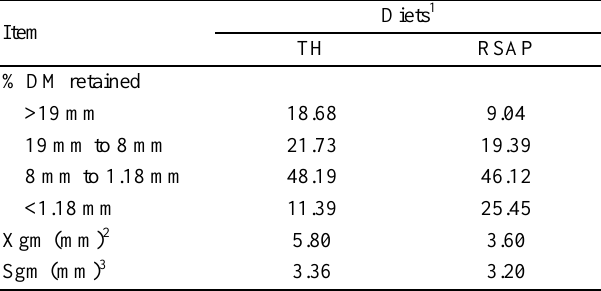
Table 2. Particle size distribution for timothy base TMR and rice straw base TMR as measured by the Penn State Particle